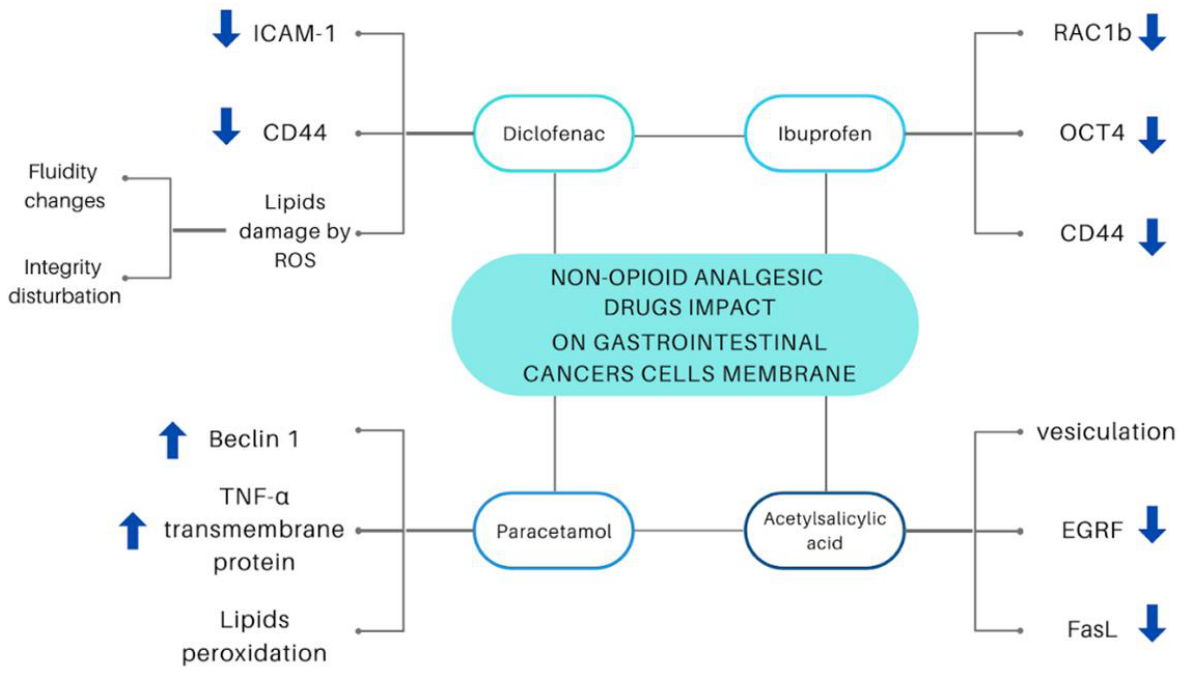
Figure 6. Changes in the lipid bilayer, including protein expression, caused by non-opioid analgesic drugs. Intracellular Adhesion Molecule-1 (ICAM-1) [53,56], antigen on a cell surface (CD44) [53–55,65], Reactive Oxygen Species (ROS) [57,58,60], Ras-related C3 botulinum toxin substrate 1B (RAC1b) [61–64], Octamer-binding transcription factor 4 (OCT40) [65], Tumor necrosis factor α (TNF- α ) [74–76], epidermal growth factor receptor (EGRF) [67,68], Fas ligand (FasL) [69,70], Beclin-1 protein [72,73].